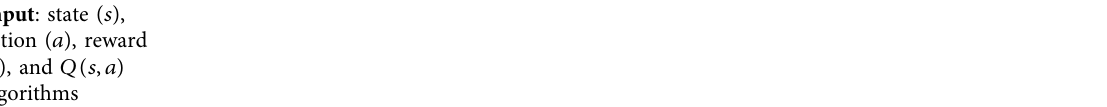
Table 2: Te procedure of the Q -learning